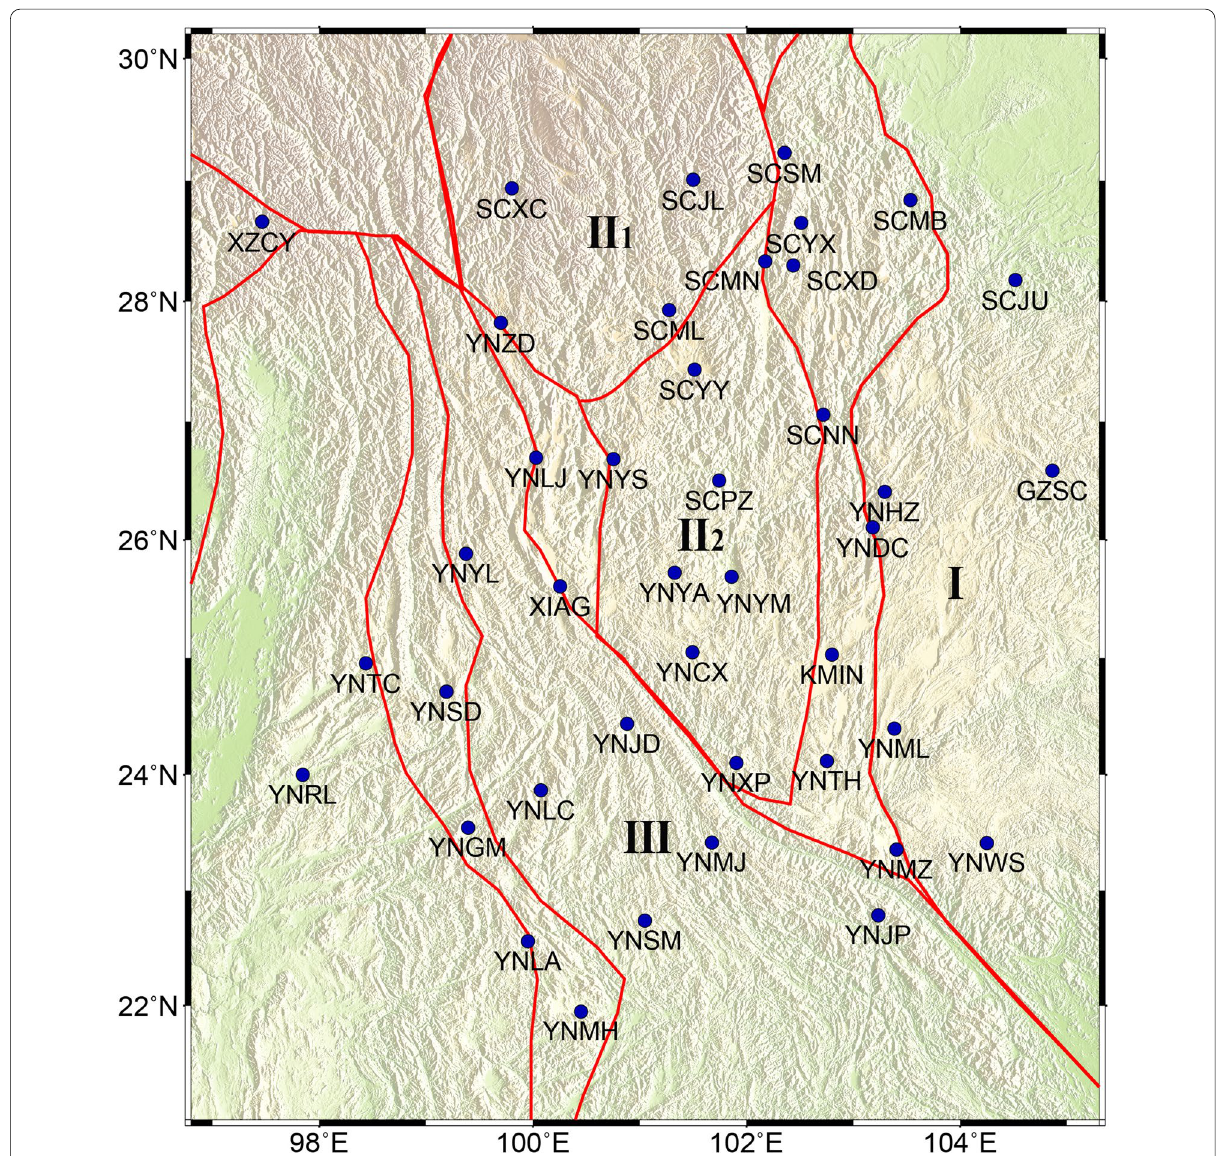
Fig. 1 Distribution of continuous global positioning system (cGPS) stations (blue dots). The red line indicates the boundary of the block (Luo et al. 2012; Zhang et al. 2003); I: South China block; II: Sichuan–Yunnan rhombic block; II 1 : West Sichuan block; II 2 : Central Yunnan block; III: Southwest Yunnan